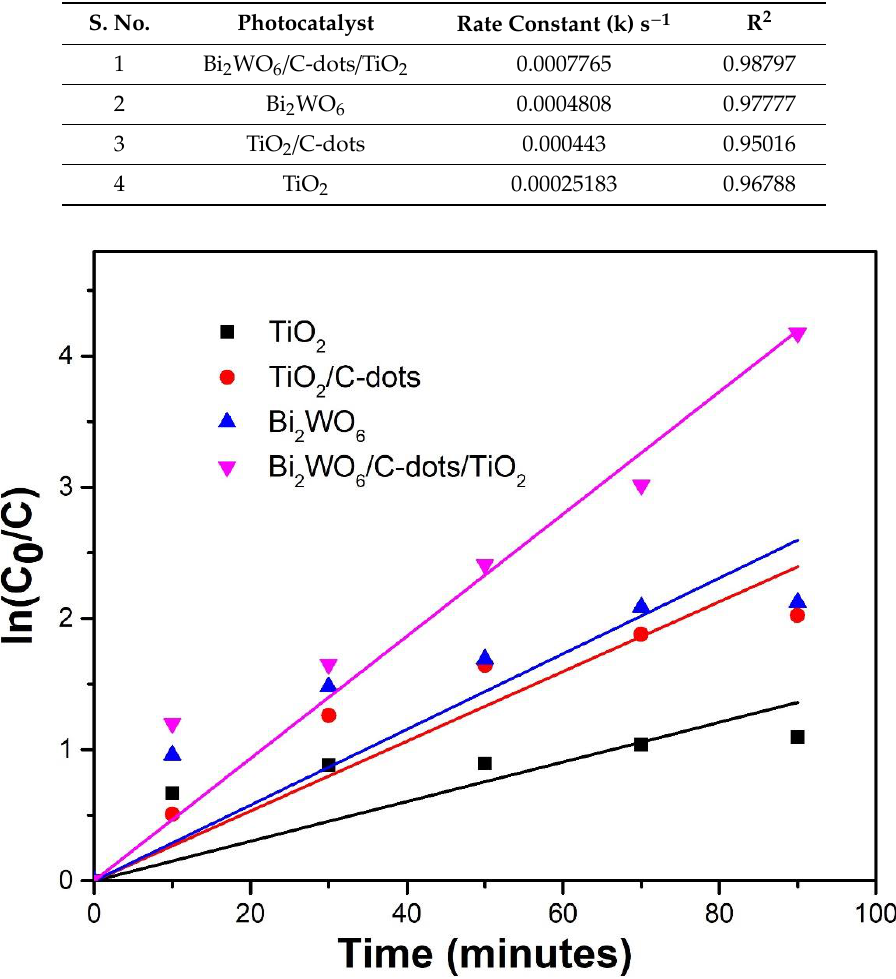
Table 2. Kinetics data of photocatalytic reaction of levofloxacin with di ff erent catalysts.